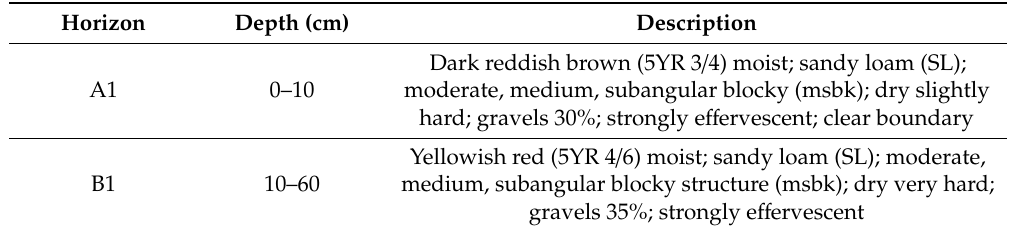
Table A18. Profile P10 horizons description.